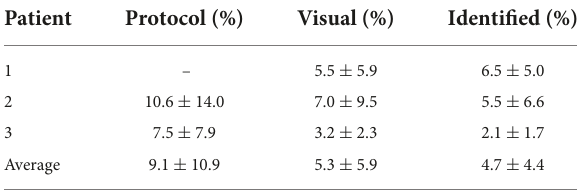
TABLE 1 Result from the identification of artifacts based on spectral content, presented as mean ± standard deviation, compared to visual observations in the time domain and artifacts as noted in the measurement protocol.